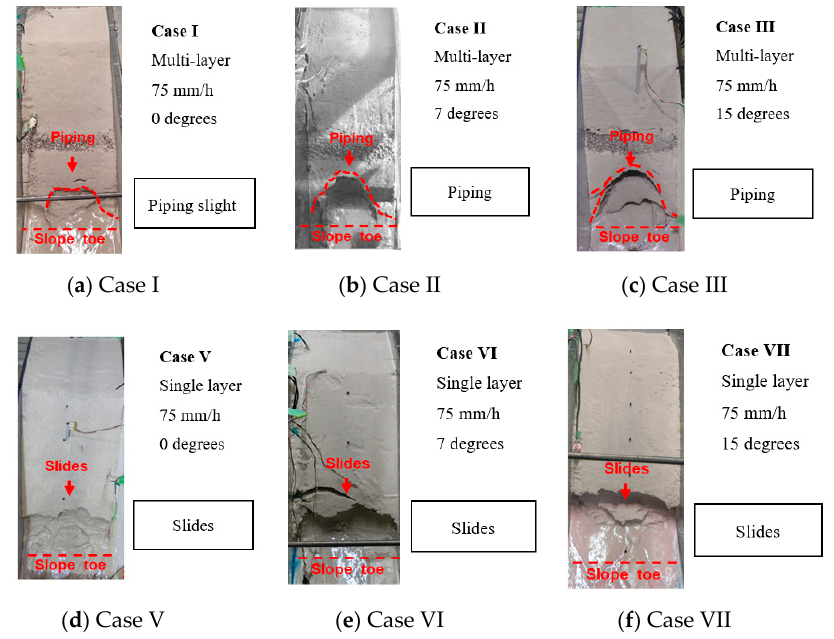
Figure 7. Comparison of failure situations of the different model experiment cases (each case was performed three times to ensure the repeatability of the results, and typical results of individual experiments were chosen to show the failure situation in each case). ( a ) case I (tilt angle α = 0 ◦ ); ( b ) case II (tilt angle α = 7 ◦ ); ( c ) case III (tilt angle α = 15 ◦ ); ( d ) case V (tilt angle α = 0 ◦ ); ( e ) case VI (tilt angle α = 7 ◦ ); ( f ) case VII (tilt angle α = 15 ◦